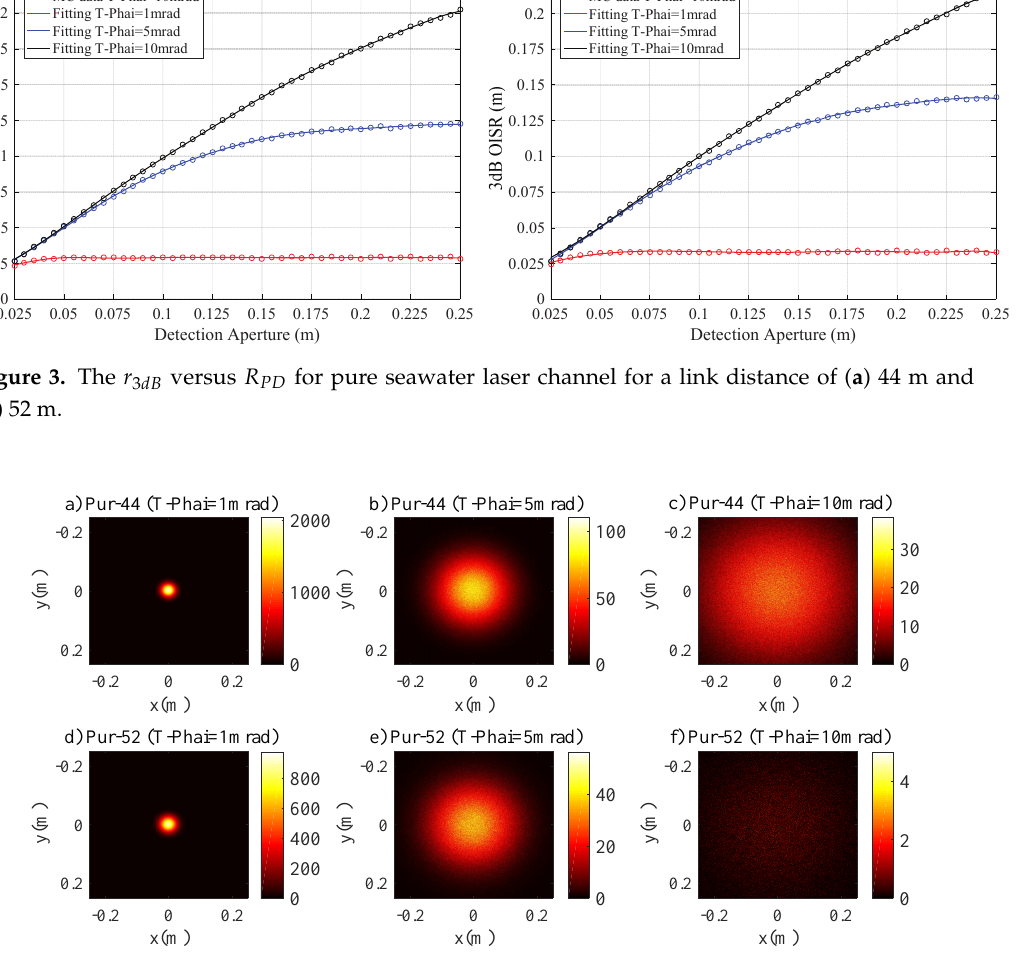
Figure 4. 2D intensity distribution of laser beam for pure seawater channel ( a ) Pur-44 with T-Phai = 1 mrad, ( b ) Pur-44 with T-Phai = 5 mrad, ( c ) Pur-44 with T-Phai = 10 mrad, ( d ) Pur-52 with T-Phai = 1 mrad, ( e ) Pur-52 with T-Phai = 5 mrad and ( f ) Pur-52 with T-Phai = 10